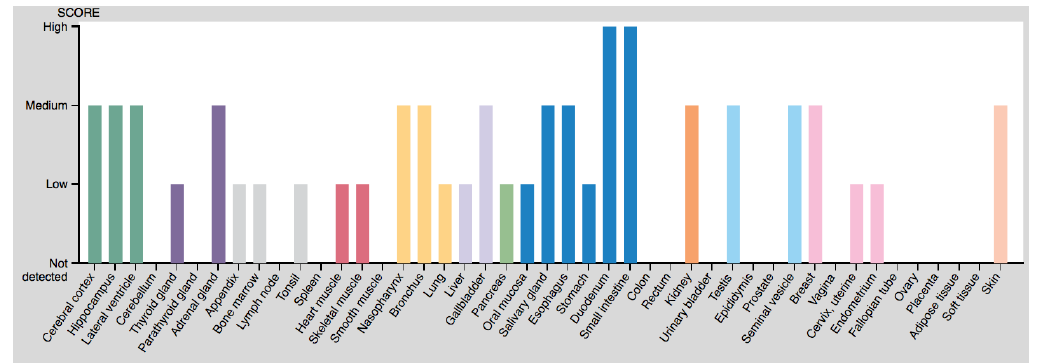
Figure 9. Protein expression scores from the Human Protein Atlas.